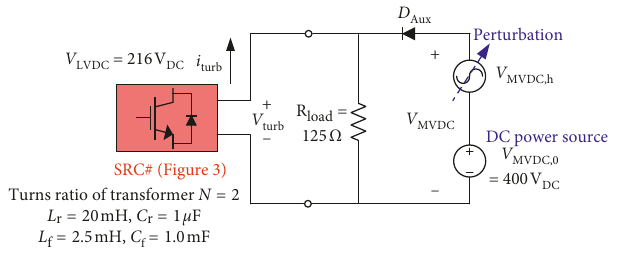
Figure 17: Schematic of the laboratory setup for experiment. Table 3: Specifications of the laboratory test bench. Low-voltage DC source, V